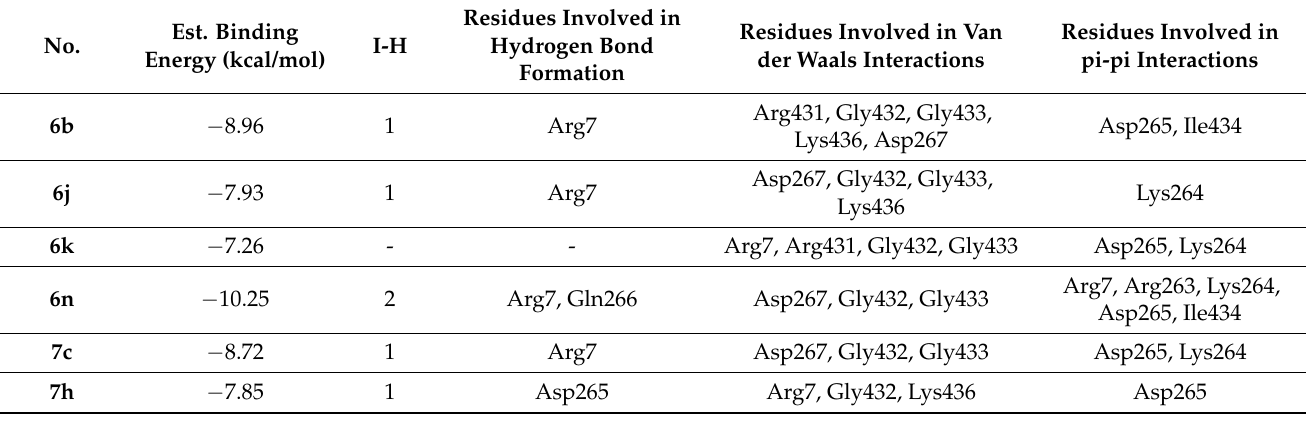
Table 8. Molecular docking scoring function that estimates free energy of binding (kcal/mol) in SERT transporter